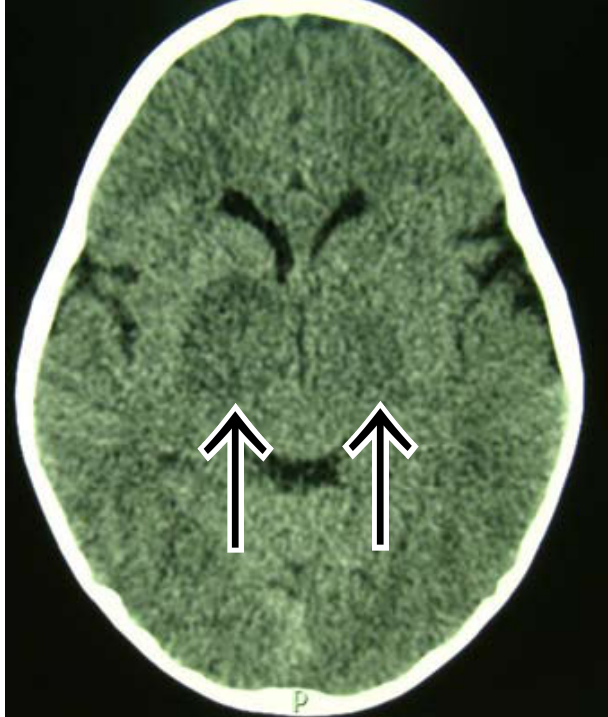
Fig. 6a. Axial non-enhanced brain CT demonstrating bilateral low-density lesions in the basal ganglia with no appreciable mass